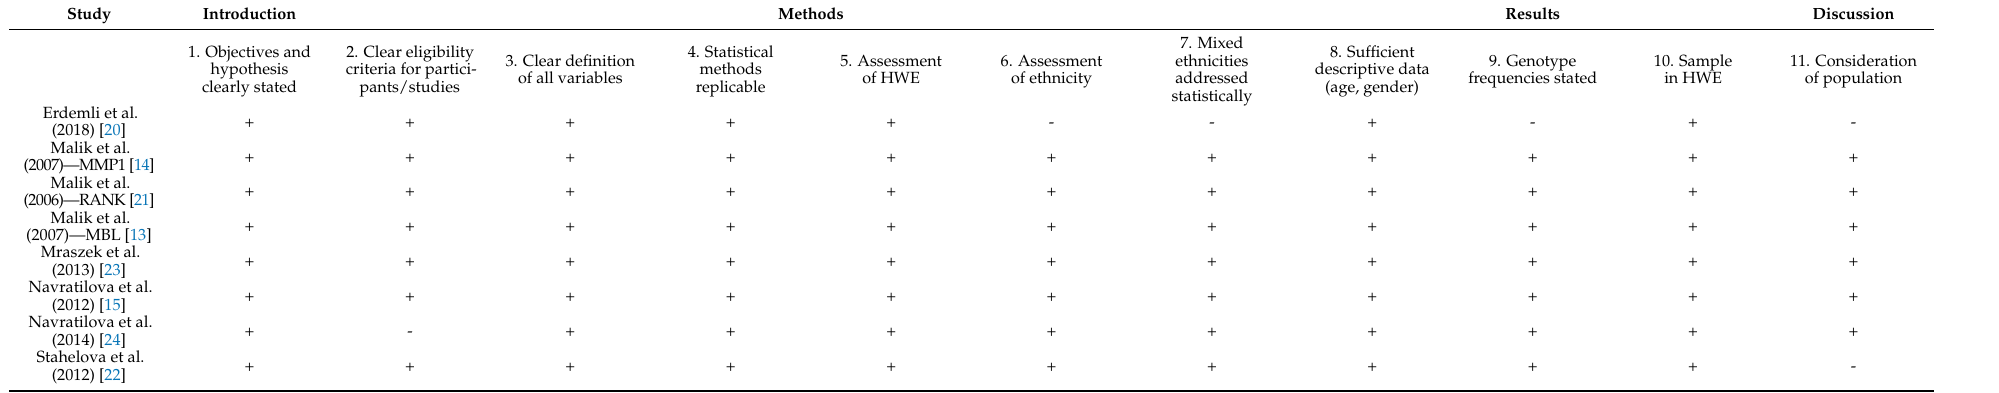
Table 2. 11-Item Quality Assessment checklist derived from STREGA/STOBE